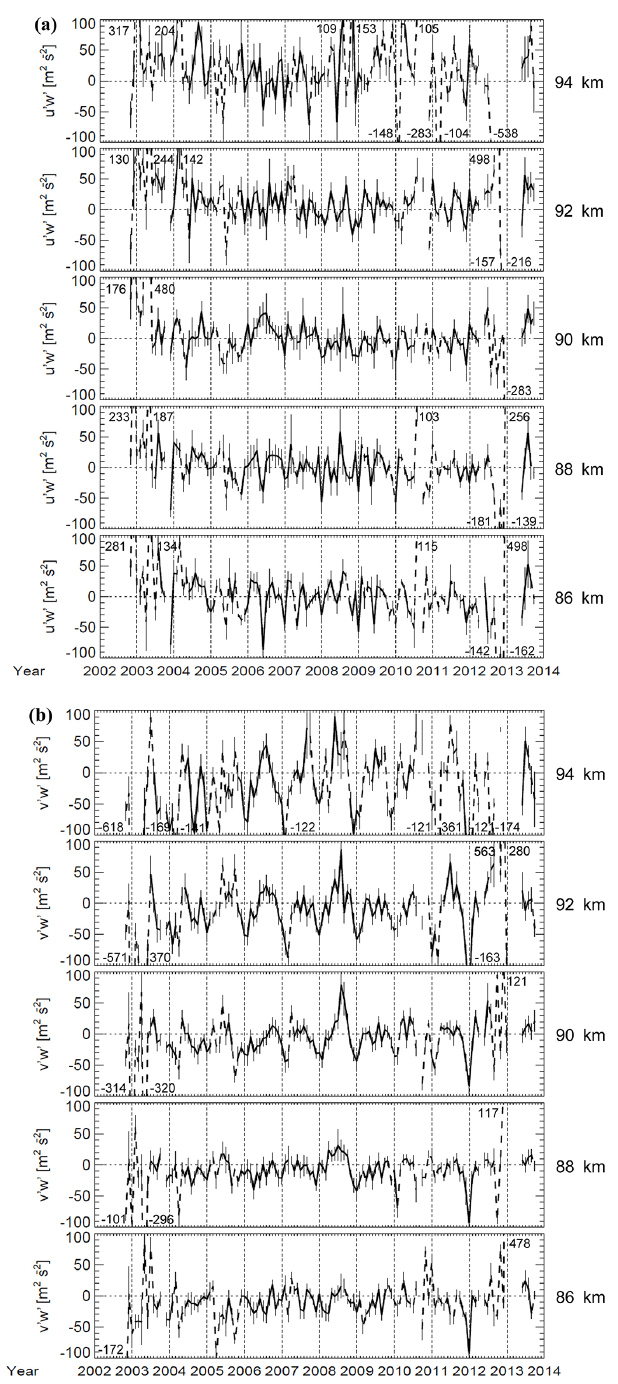
Figure 2. Monthly mean (a) u (cid:48) w (cid:48) and (b) v (cid:48) w (cid:48) obtained from the meteor radar at Koto Tabang from November 2002 to Novem- ber 2013 at 86–94km. Solid and dashed lines show u (cid:48) w (cid:48) and v (cid:48) w (cid:48) when the number of bins was larger or smaller than 100, respec- tively. The numbers in each panel indicate an exceeded value.